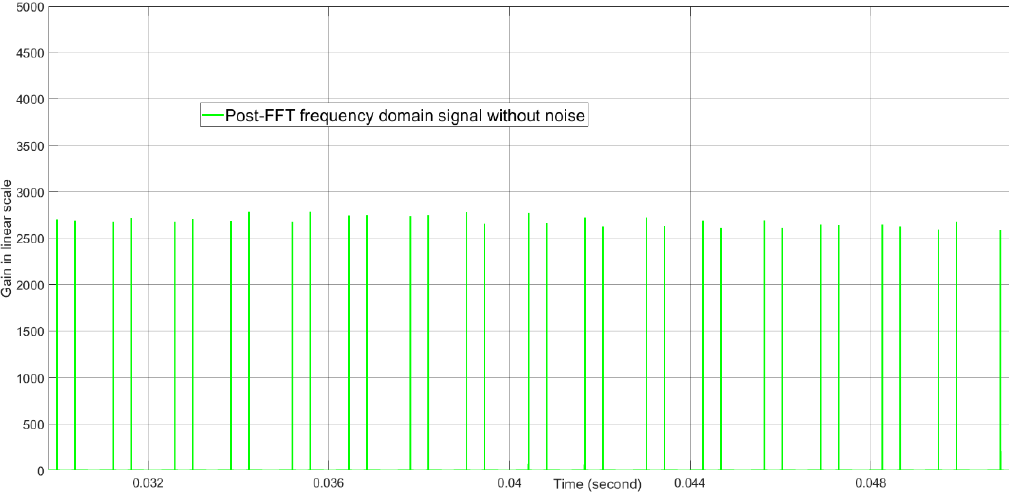
Figure 14. The post-FFT desired tone energy without noise when the initial Doppler estimate has an error of − 1.783 × 10 − 5 ( − 55.7 Hz) at about 0.04 s real time. This result is generated by computer simulation, not by FPGA simulation.